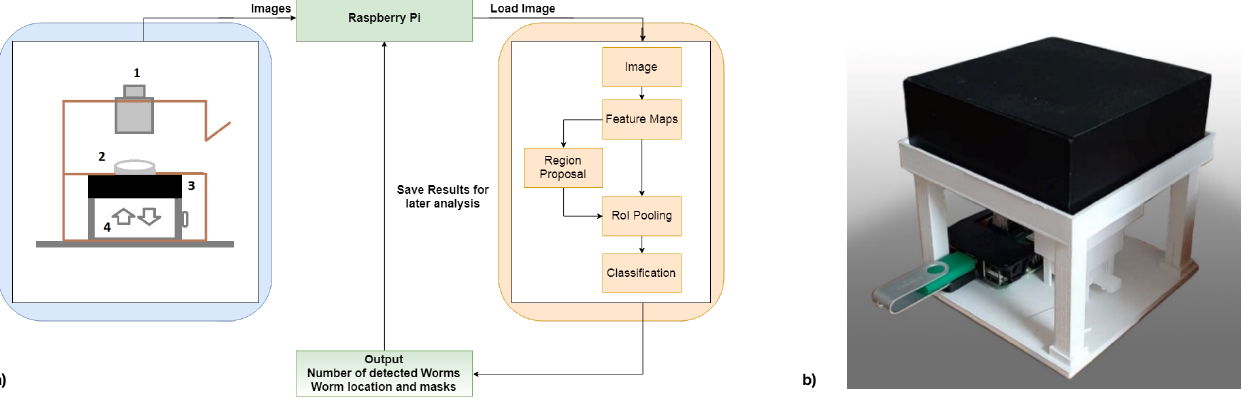
Figure 1. ( a ) Schematic of the whole prototype system structure. The hardware, on the left, consists of (1) the camera module with lenses, (2) the agar plate with C. elegans, (3) the lighting system, reused from [13] and (4) a movable stage to determine the correct distance to the lenses and thus guarantee sharp images (only in this prototype system, distance will be fixed later). The Pi saves taken images on itself. Loading an image into the detector yields the number of detected worms and corresponding bounding boxes and masks, which can be drawn onto the original image or saved separately. ( b ) A subsequent version of the DIY microscope, where the optics and lighting has been flipped